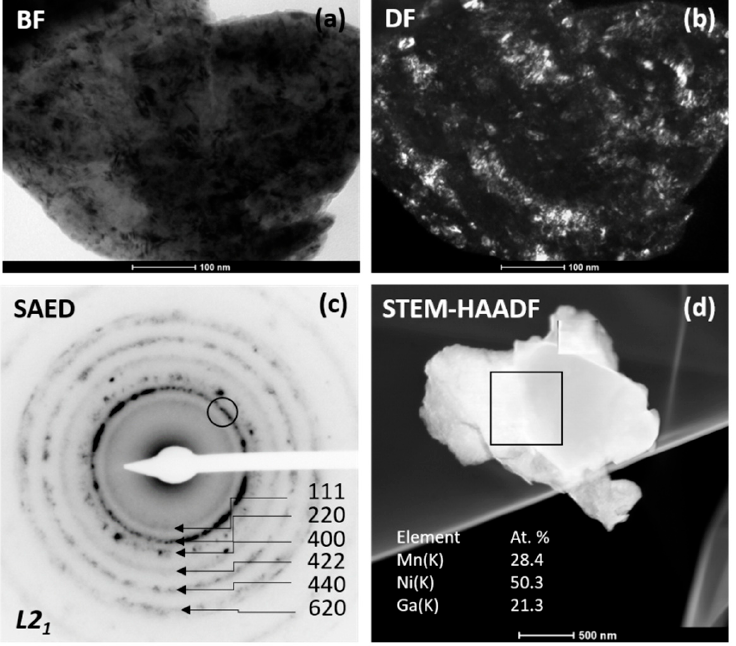
Figure 3. TEM bright field ( a ), dark field ( b ), selected area electron diffraction ( c ), and STEM-HAADF ( d ) images taken at room temperature from the powders after 8 h milling and annealing at 1173 K for 1 h.